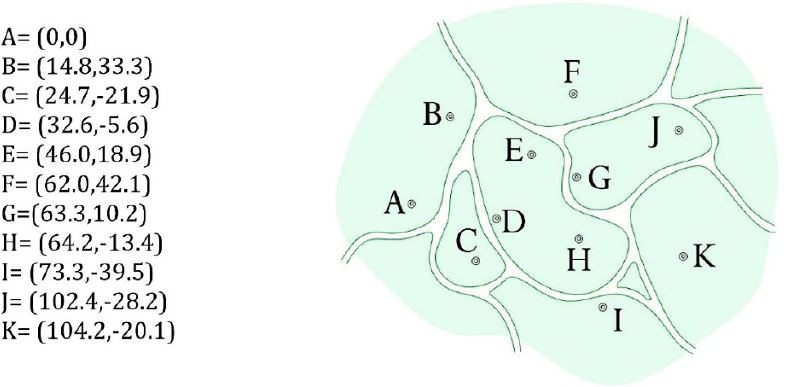
Figure 2. Forest study area. Own source.